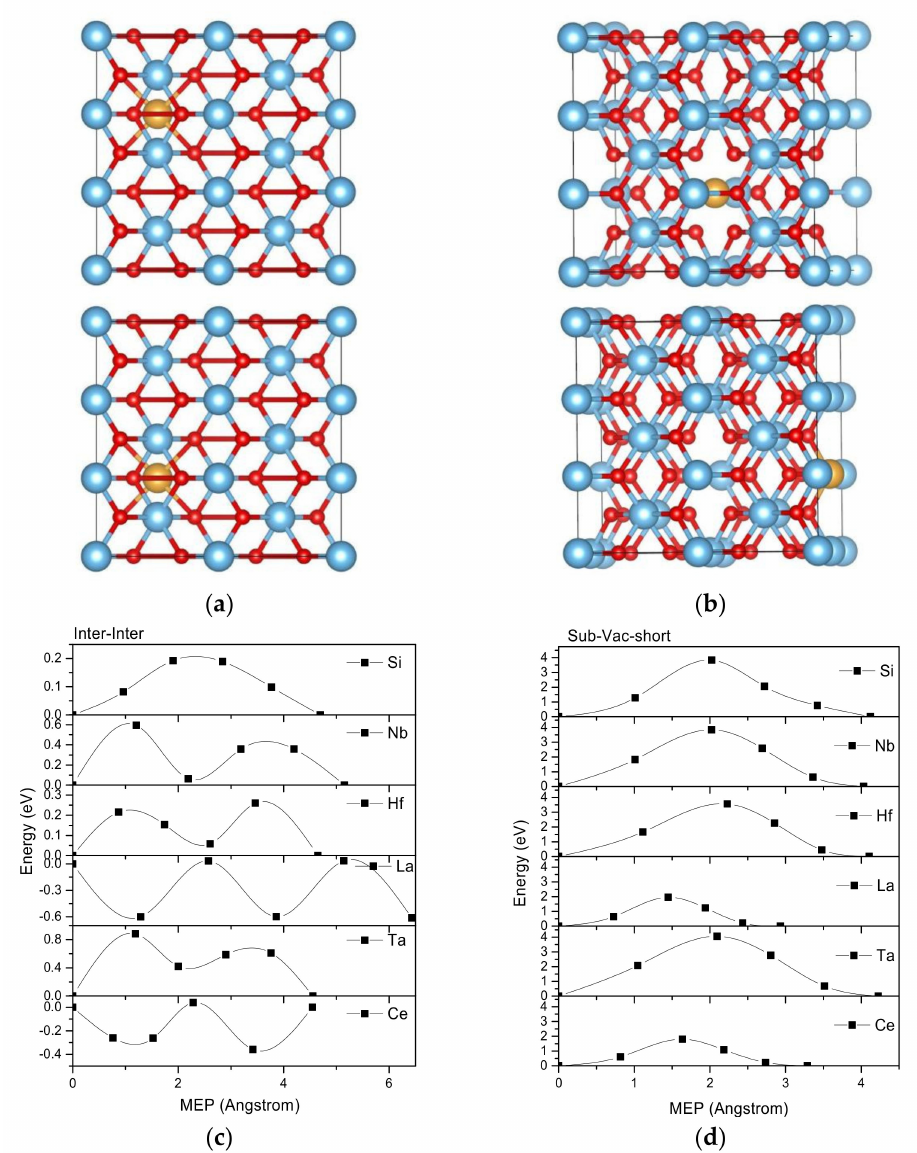
Figure 5. The diffusion paths of alloying element in TiO 2 system (side views). ( a ) Inter-Inter, ( b ) Sub- Vac-long, and the minimum energy path (MEP) of ( c ) Inter-Inter, ( d )